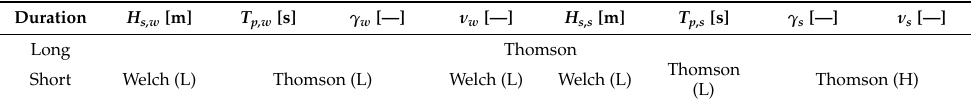
Table 10. Selection of spectrum estimation methods (H: high frequency; L: low